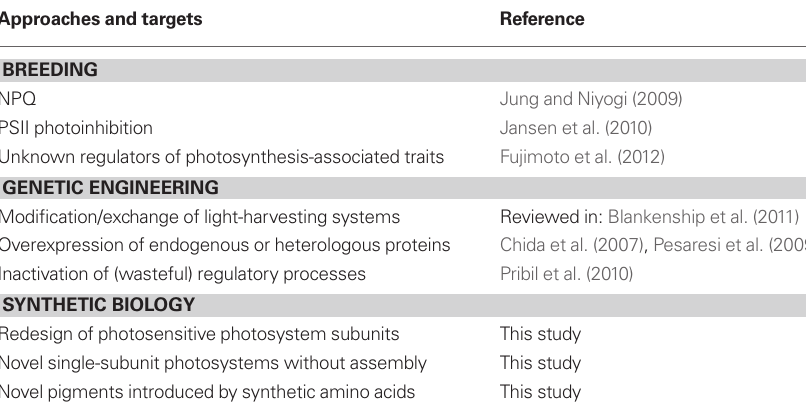
Table 1 | Overview of approaches to improving photosynthetic light reactions. Approaches and